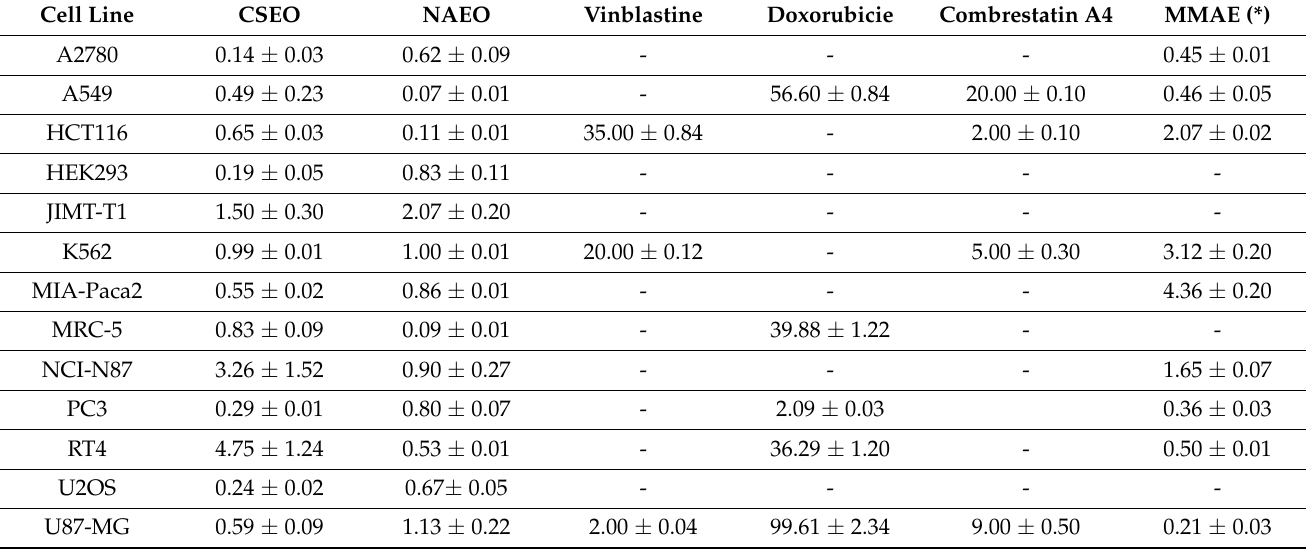
Table 5. IC 50 ( µ g/mL) values for the evaluation of CSEO and NAEO in the cytotoxicity test against the cancer